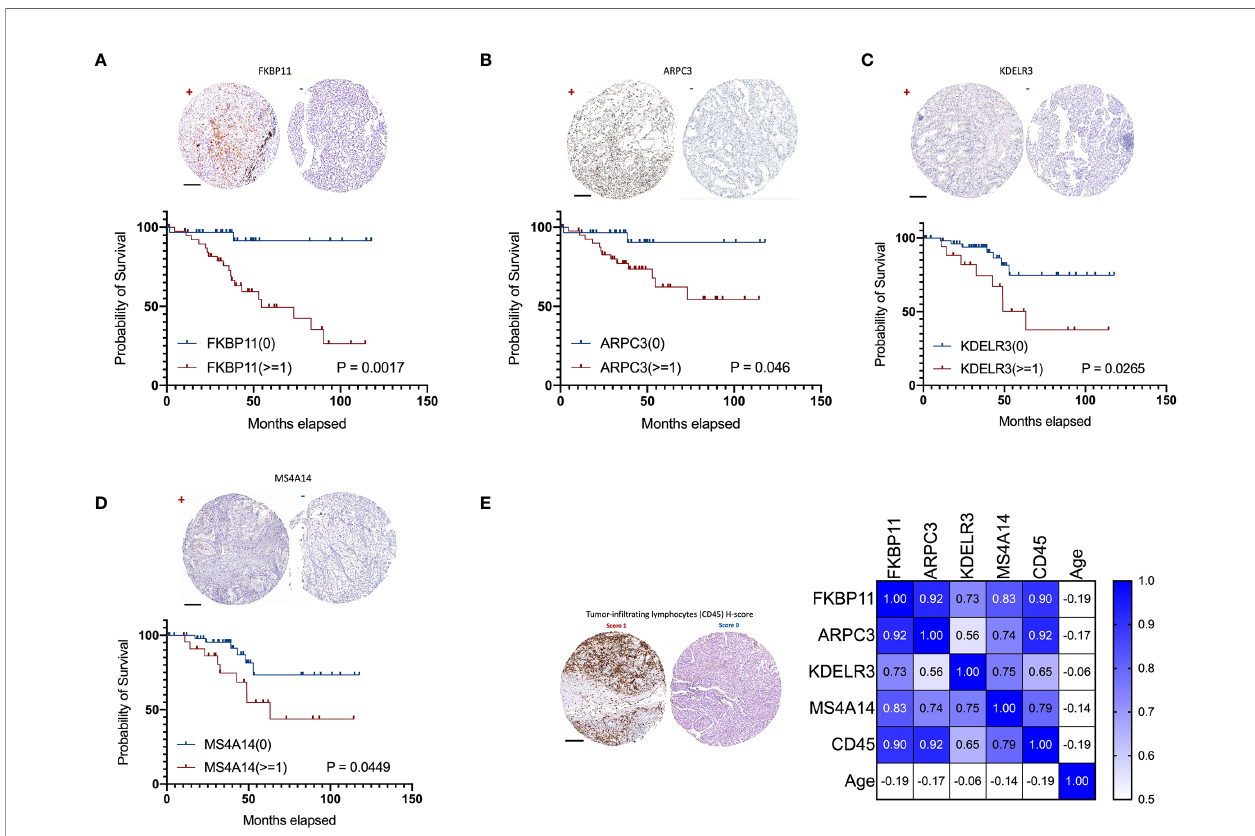
FIGURE 11 | Validation of ADCP-related genes in 72 in-house ccRCC samples. Shown were representative IHC images ( “ + ” for score >=1 and “ - ” for score 0) and impact on overall survival of (A) FKBP11, (B) ARPC3, (C) KDELR3, and (D) MS4A14. (E) Representative H-score 1 and 0 for TIL abundance and heatmap for its correlations with ADCP-related genes and age (Spearman ’ s r). (Scale bar = 200 µm).